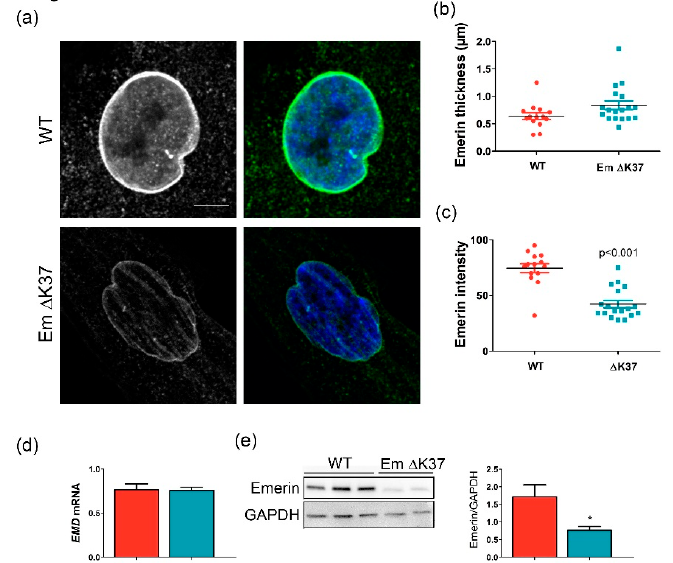
Figure 2. Mutation Δ K37, most commonly found in patients with atrial cardiac defects (ACD), causes emerin degradation in cells grown on hard substrate. ( a ) Representative immunofluorescence images of emerin localization in wild-type (WT) and Δ K37 myofibroblasts. DNA is stained in blue using Hoechst 33,342 and emerin in green. Scale bar, 10 µm. ( b ) Scatter plots of emerin nuclear envelope staining thickness (µm) in wild-type (red) and Δ K37 (blue) myofibroblasts. ( c ) Scatter plots of emerin nuclear envelope staining intensity in wild-type (red) and Δ K37 (blue) myofibroblasts. ( d ) Emerin mRNA expression in wild-type (red) and Δ K37 (blue) myofibroblasts. EMD gene expression was normalized to RPLP0 . Data represent mean and SEM ( n = 3 for each cell line). ( e ) Typical western-blot of emerin protein expression in wild-type and Δ K37 myofibroblasts, and mean emerin protein levels in wild-type (red) and Δ K37 (blue) myofibroblasts (normalized to Glyceraldehyde-3-Phosphate Dehydrogenase, GAPDH). Data represent mean and SEM ( n = 7 in WT, n = 6 in Δ K37). * p < 0.05.